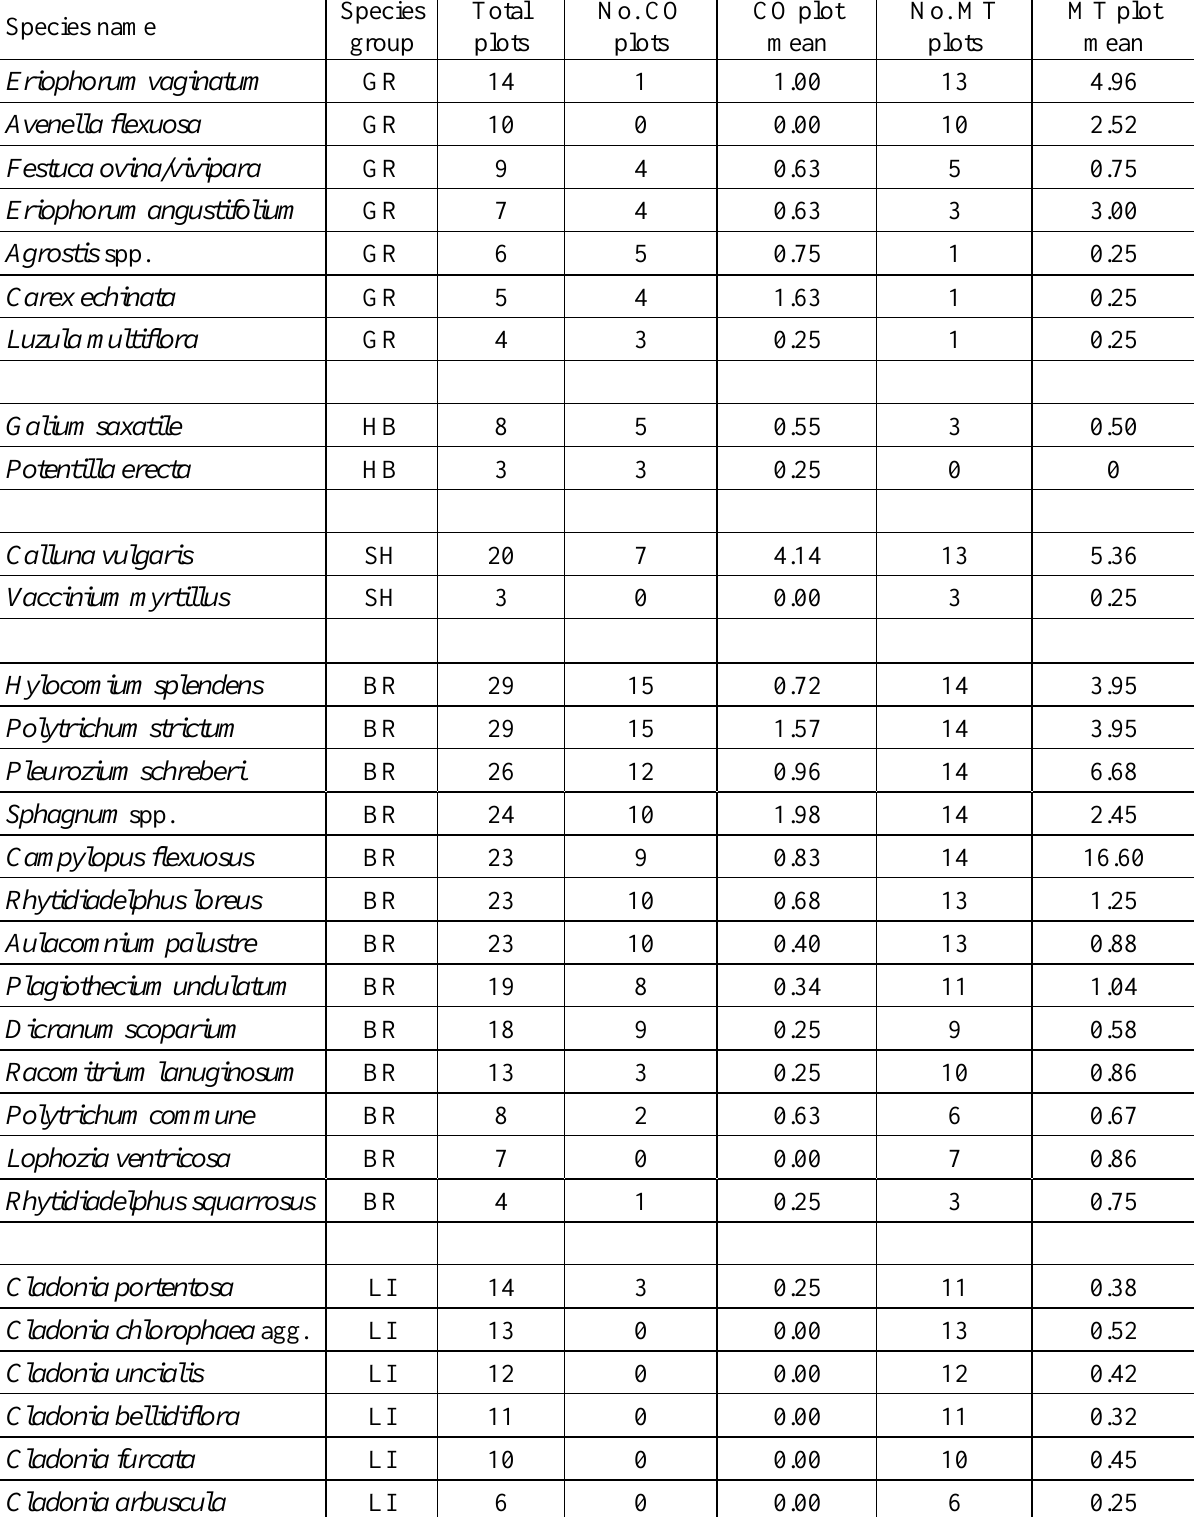
Table 3. Frequency (number of occupied plots) and mean percent cover of species at CO (Coire Odhar) and MT (Meall nan Tarmachan) in the fourth year after treatment (2019). Only species that were recorded in at least three plots at either site are given, and mean percent cover has been calculated for those plots in which they occurred. Species are arranged in descending order of frequency and grouped by species group